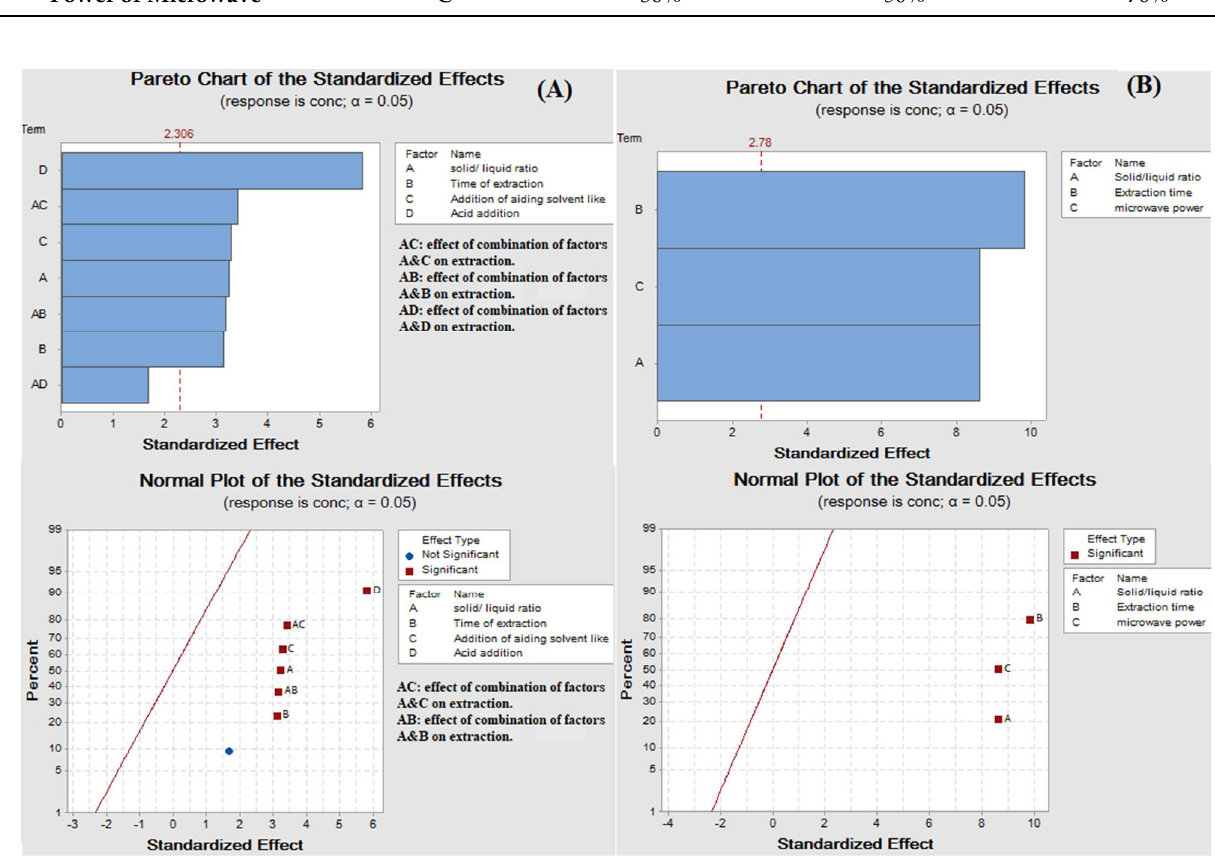
Figure 1. ( A ) Pareto chart and normal plot of the standardized effects of ultrasound-assisted glycerol extraction and ( B ) Pareto chart and normal plot of the standardized effects of microwave aided extraction.